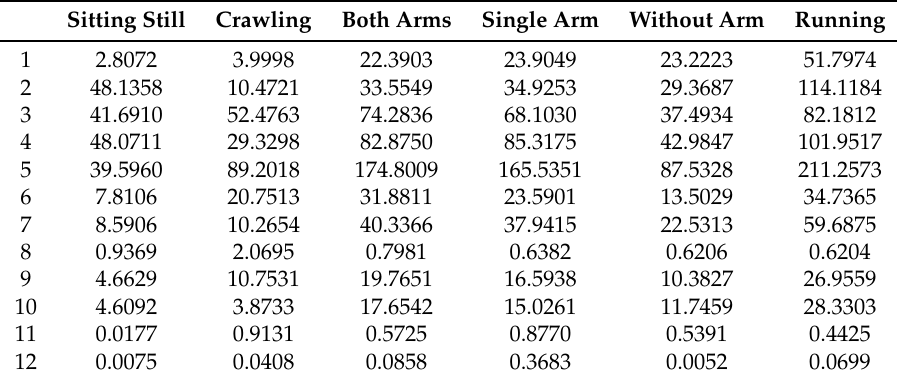
Table 4. Characteristic values of six states of motion.